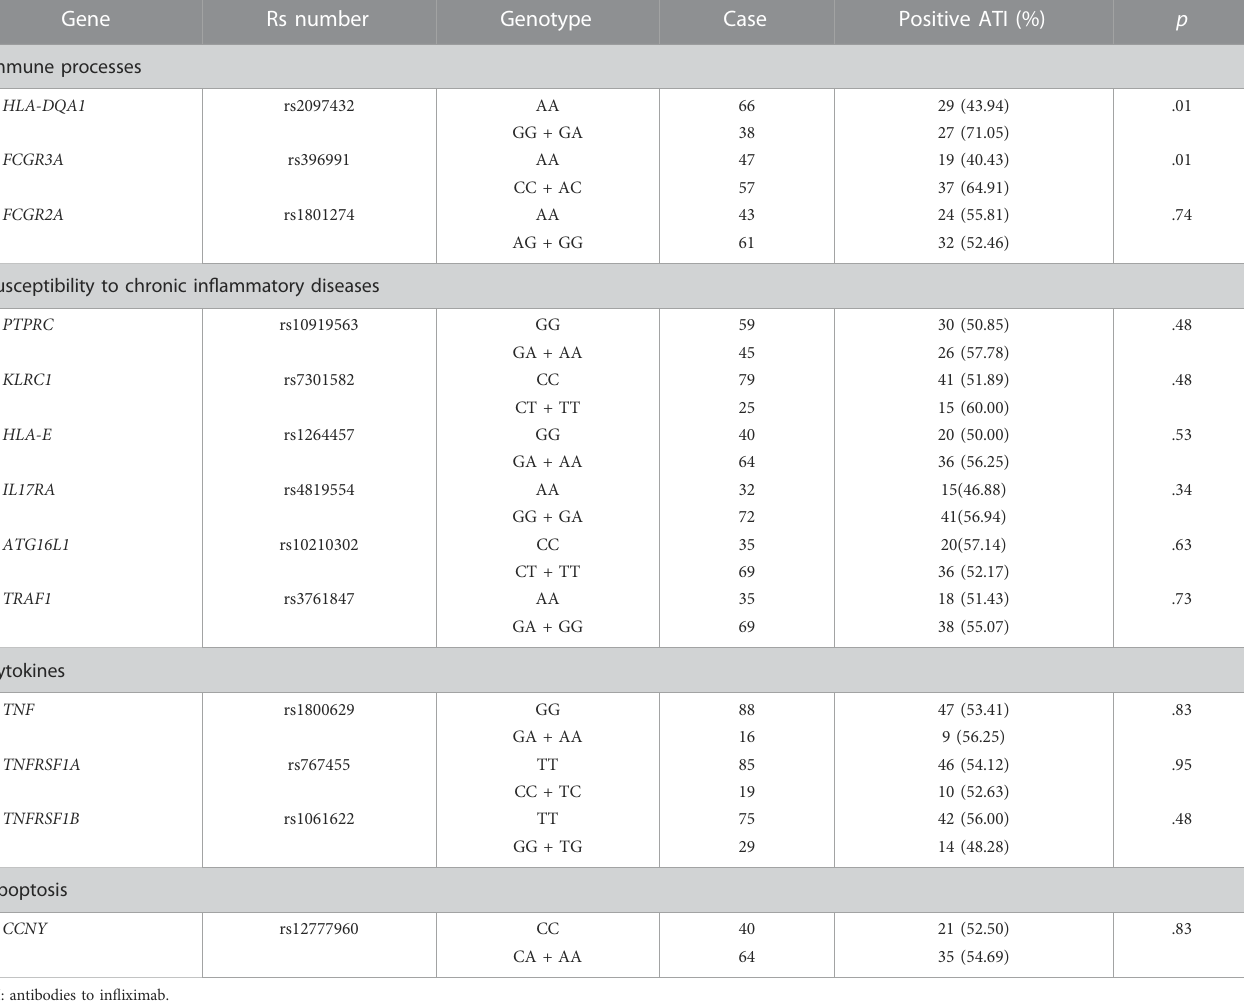
TABLE 2 Patients who developed antibodies to in fl iximab according to single nucleotide polymorphisms (SNPs) under IKthe dominant model.